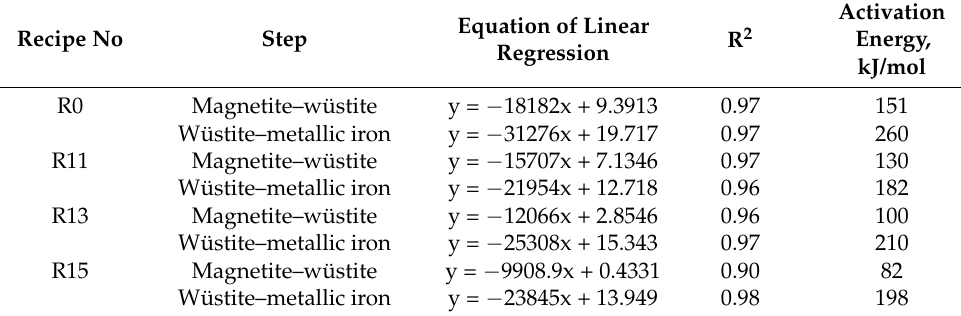
Table 6. The estimated apparent activation energies for different iron oxide reduction